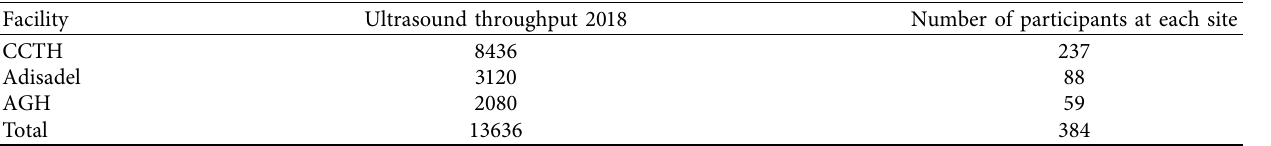
Table 1: Sample size determination for each site.